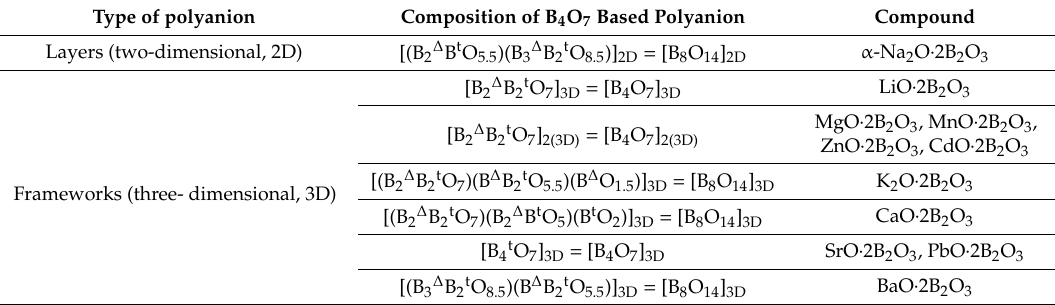
Table 2. Polyanions with [B 4 O 7 ] n and [B 8 O 14 ] n radicals.